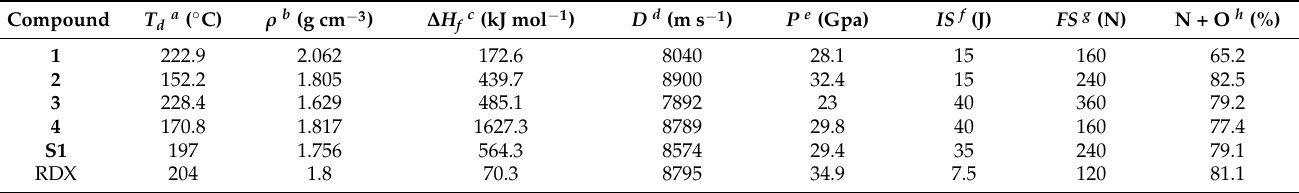
Table 1. Physicochemical and energetic properties of compounds 1 , 2 , 3 and 4 .